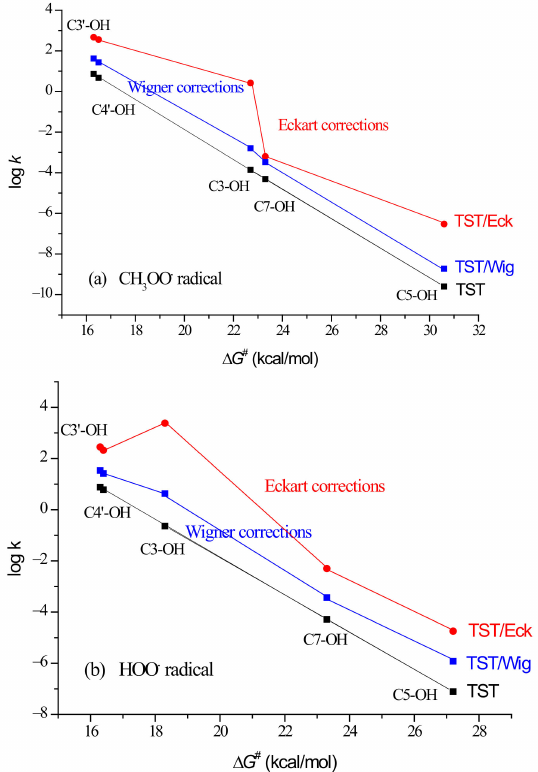
Figure 2. Influence of tunnelling corrections on the kinetics of the reaction between